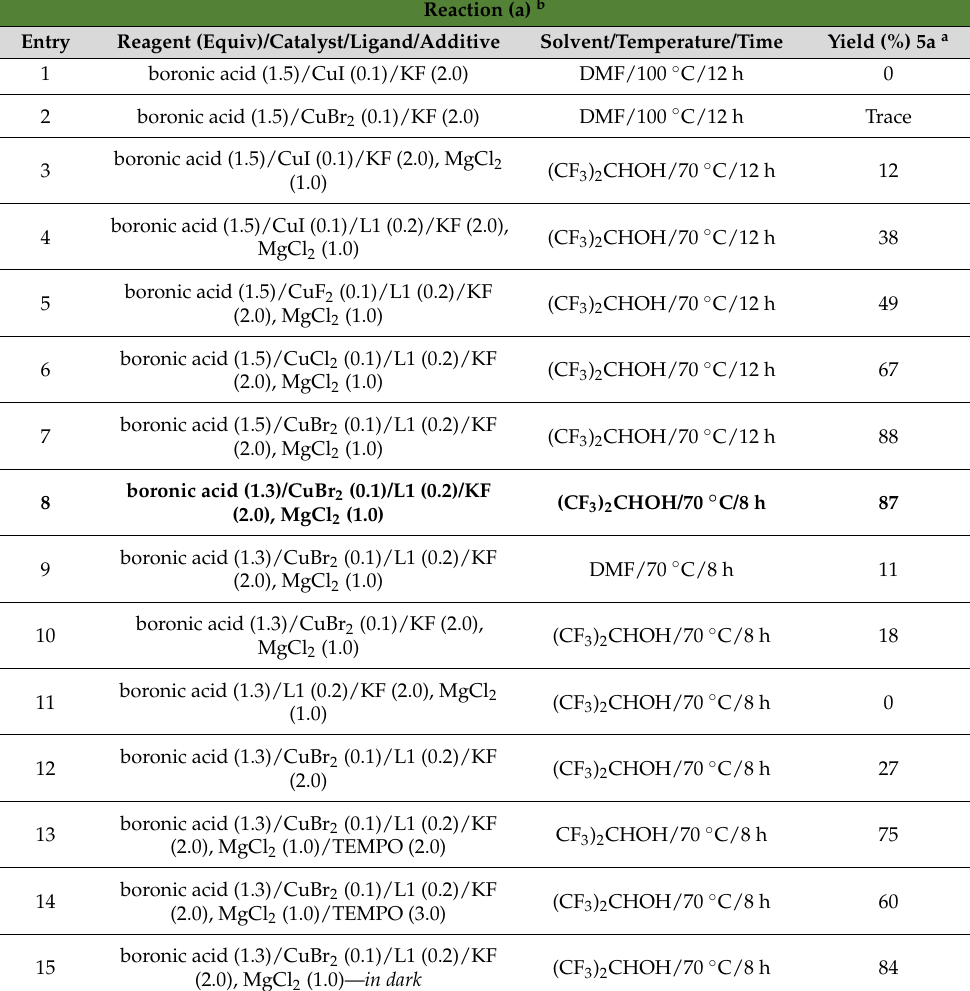
Table 1. Optimization of the reaction conditions for synthetic protocol (a).